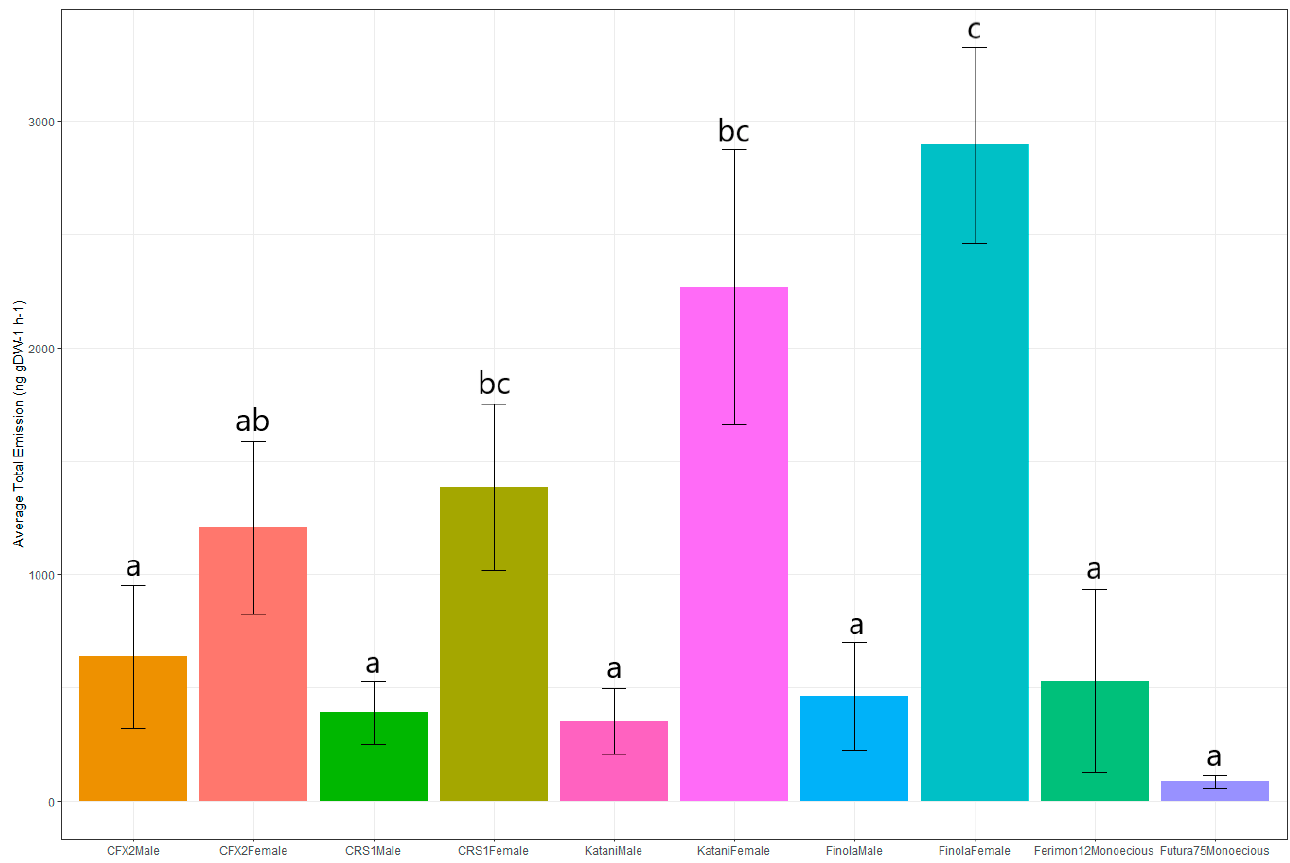
Figure 3. Total VOC emissions (ng g DW − 1 h − 1 ) from six New Zealand grown hemp cultivars (four dioecious and two monoecious). Datasets for dioecious cultivars are separated by sex (male or female). Data are presented as mean ± SEM ( n = 80). Different letters indicate a significant difference in emissions between the cultivar × sex interactions.